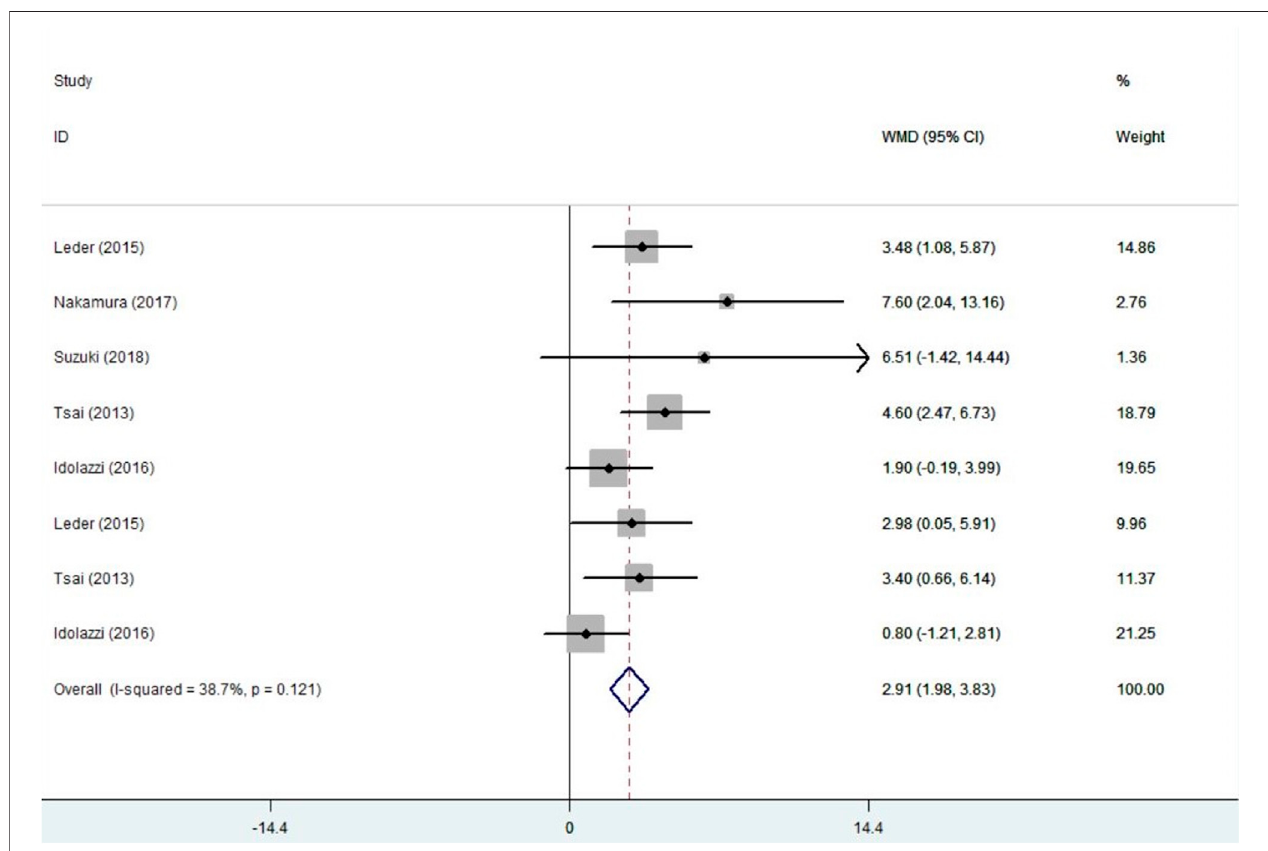
FIGURE 2 | Forest plot for the lumbar spine BMD